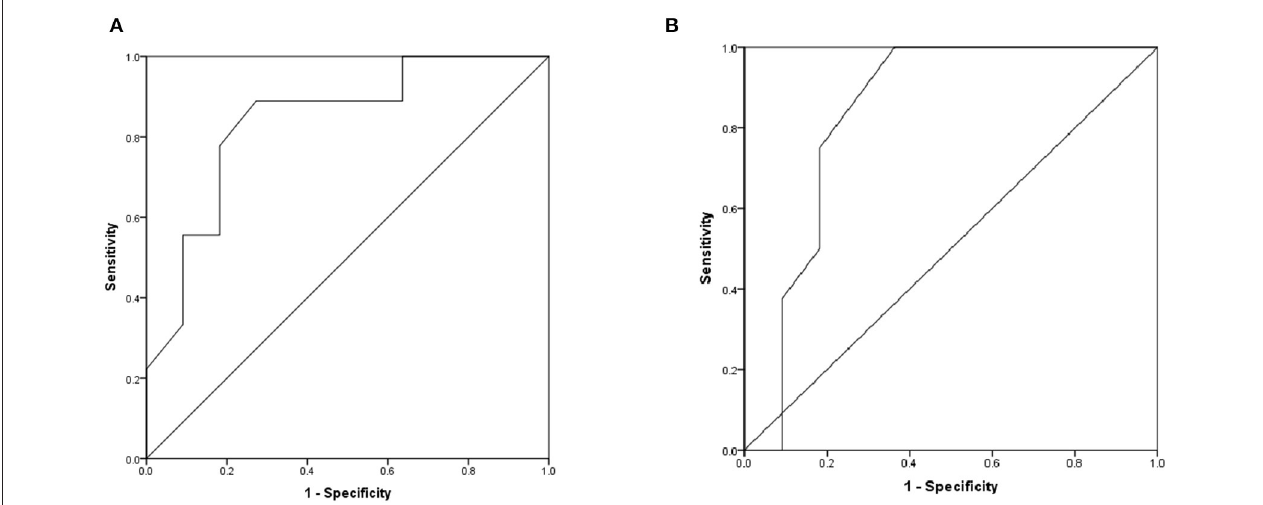
FIGURE 6 | The ROC curve of predictive values on DCM prognosis. (A) The difference of T-wave amplitude difference in lead aVR before and after treatment. (B) The difference of QT interval difference in lead V 6 before and after treatment.